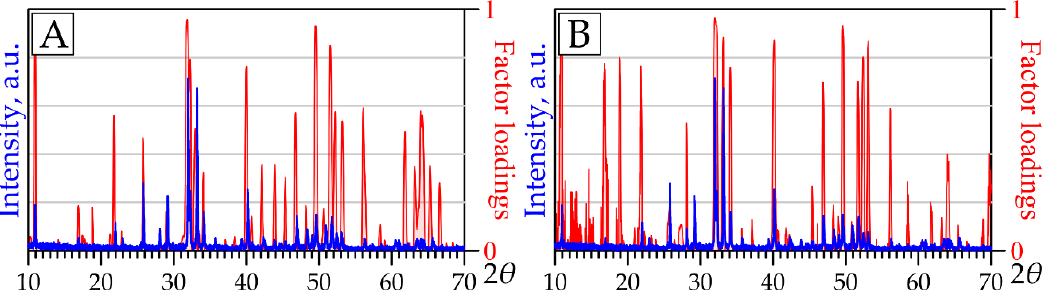
Figure 9. Comparison of the fluorapatite diffraction pattern from the RRUFF database (ID R050122, blue line) with the FL graph of the fluorapatite factor (red line): ( A ) for Kontozero rocks (this study); ( B ) for the rocks of the Petyayan-Vara occurrence (Vuoriyarvi massif, NW Russia) from [4].